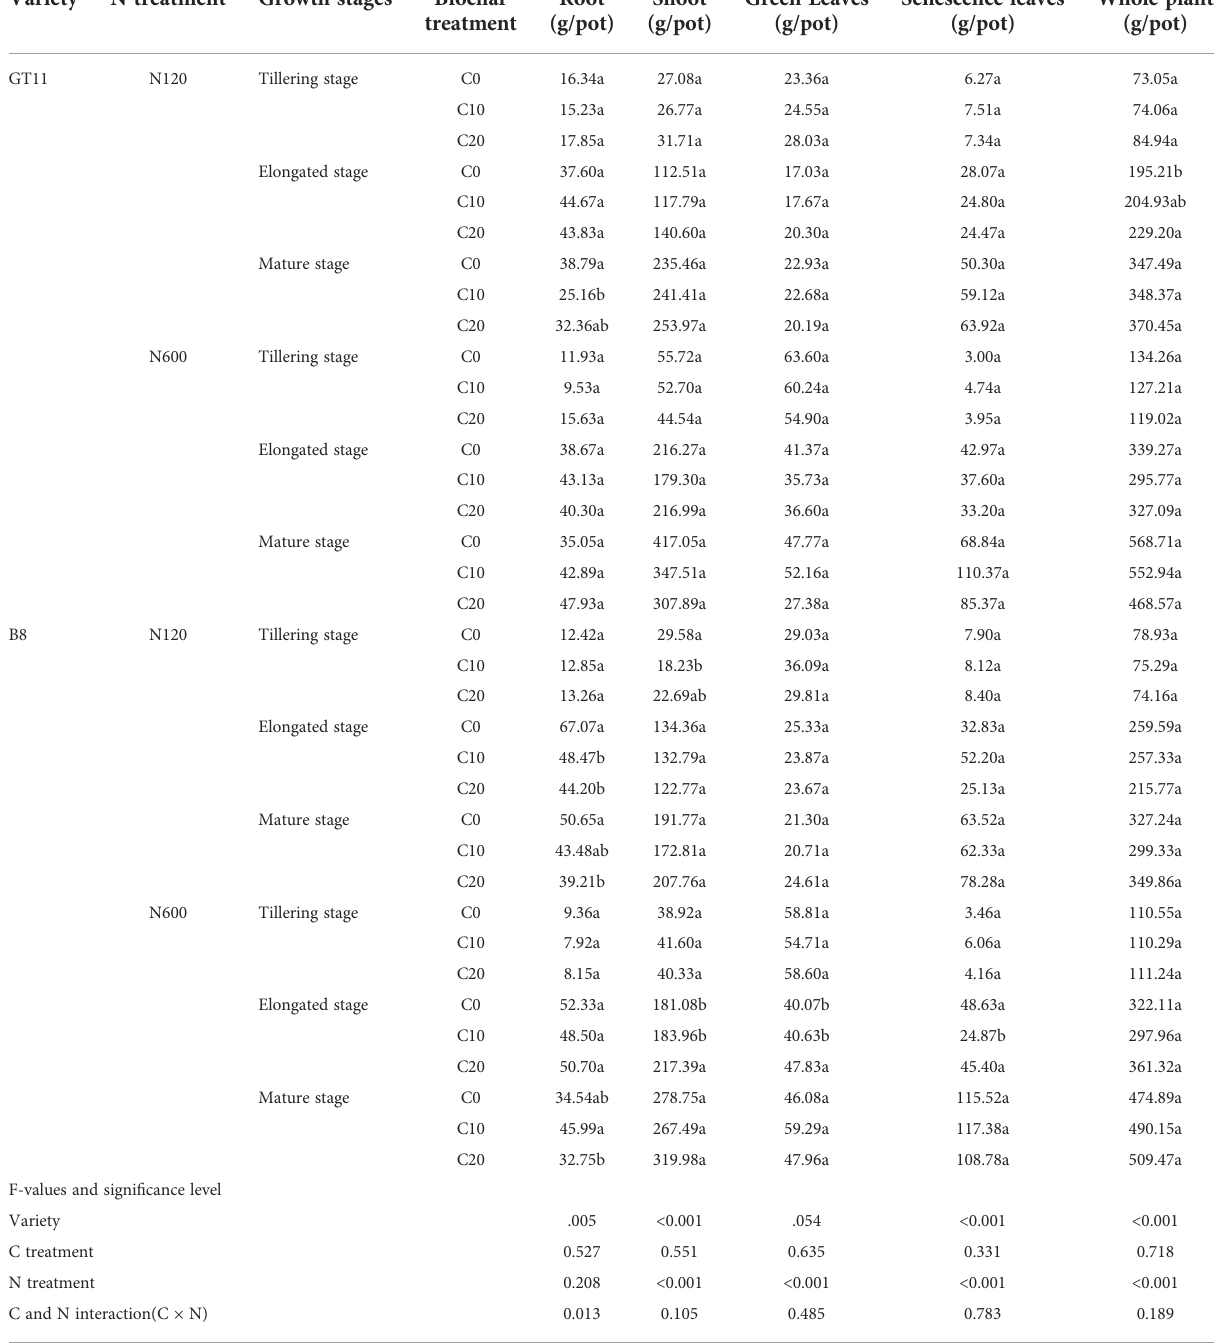
TABLE 1 Effects of biochar and N fertilizer treatment on dry weight(DW) of two sugarcane varieties. Variety N treatment Growth